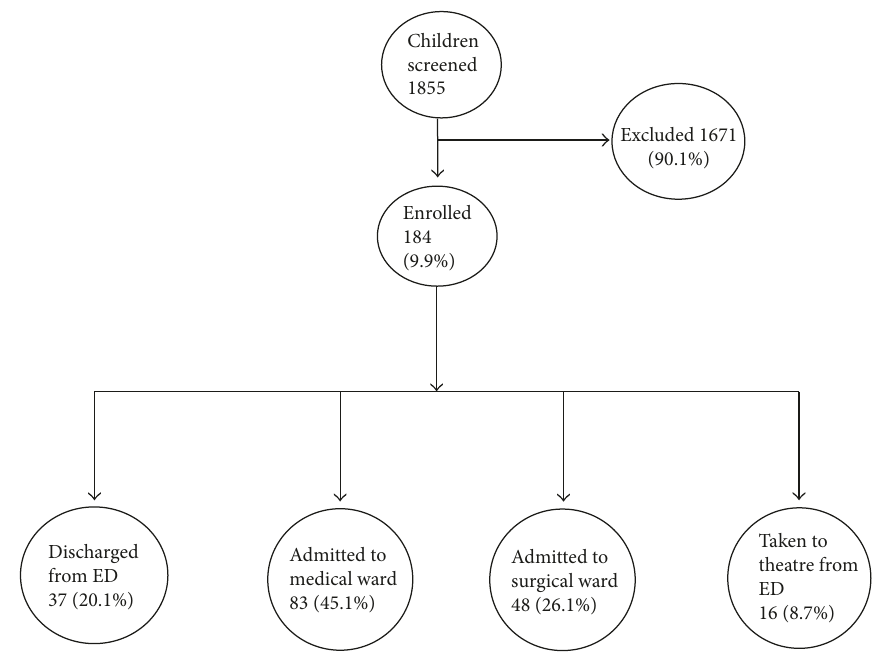
Figure 1: Screening and disposition of children presenting to the ED-MNH with abdominal pain.